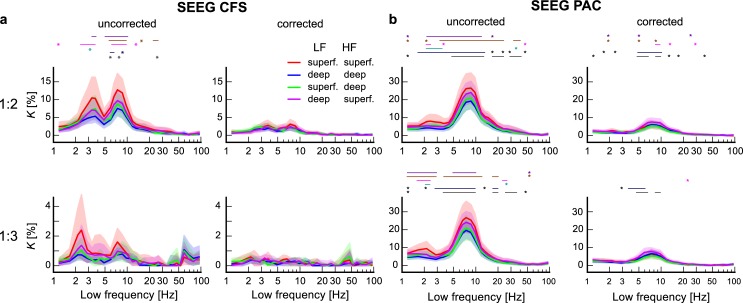
CFS and PAC in different laminar depths in SEEG data.(a) Connection density K for uncorrected (left) and corrected (right) interareal CFS at ratio 1:2 (top row) and 1:3 (bottom row) in SEEG among electrode pairs that were either both in more superficial (s) layers (red) or both in deeper (d) layers (blue), when the LF electrode was in a more superficial layer and the HF electrode in a deeper layer (green), and vice versa (purple). The colored bars and stars indicate LFs at which K values were significantly different between laminar depth combinations (Wilcoxon test, p < 0.05, corrected) (purple: s–s versus d–d; beige: s–s versus s–d; pink: s–s versus d–s; turquoise: d–d versus s–d; dark blue: d–d versus d–s; gray: s–d versus d–s). (b) Same for interareal PAC in SEEG data. In both CFS and PAC, for the uncorrected data, the connection densities were highest for connections in which both electrodes were localized within superficial layers and lowest for both localized within deeper layers. In corrected PAC, K was highest when LF electrodes were localized to deeper and HF to superficial layers and lowest when vice versa. Plot data and underlying connectome data are available online at https://datadryad.org/stash/dataset/doi:10.5061/dryad.0k86k80. CFS, cross-frequency PS; HF, high frequency; LF, low frequency; PAC, phase–amplitude coupling; PS, phase synchrony; SEEG, stereoelectroencephalography.